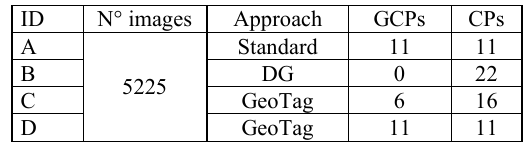
Table 2. Processing strategy 2, georeferencing approach and GCPs/CPs